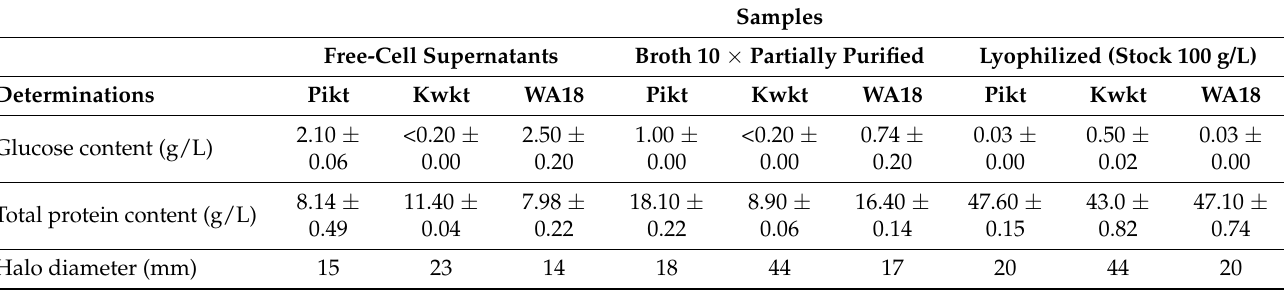
Table 1. Determination of glucose, total protein content and diameter of inhibition halo of free- cell supernatant and broth 10 × partially purified, as middle downstream process, and D2, D15 and D18 lyophilized melted in water. Data regarding glucose and total protein contents were reported as mean values ± standard deviations. The killer toxin activity was evaluated against the Brettanomyces bruxellensis sensitive